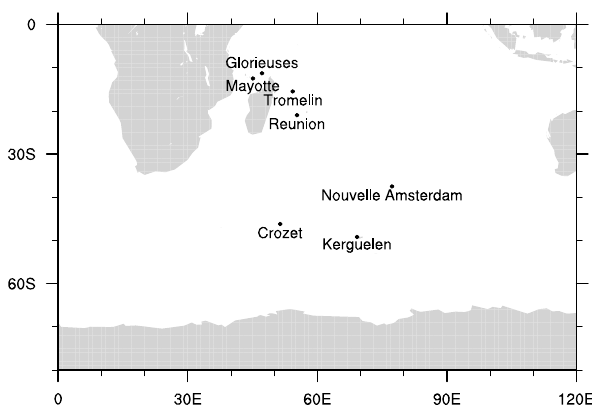
Figure 1. Map of the French islands in the Indian Ocean. The different coordinates are given from low to high latitudes: Glo- rieuses (47.2 ◦ E, 11.3 ◦ S), Mayotte (45.1 ◦ E, 12.5 ◦ S), Tromelin (54.3 ◦ E,15.5 ◦ S), Réunion (55.3 ◦ E, 21.0 ◦ S), Nouvelle Amster- dam (77.3 ◦ E, 37.5 ◦ S), Crozet Islands (51.4 ◦ E, 46.2 ◦ S) and Ker- guelen Islands (69.2 ◦ E, 49.2 ◦